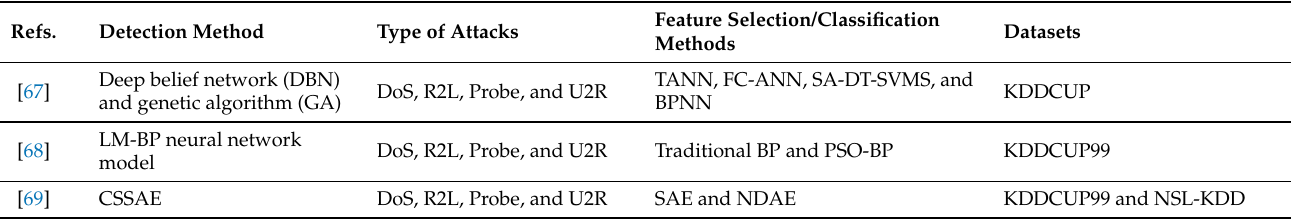
Table 6. Deep learning methods for cyber attack detection in